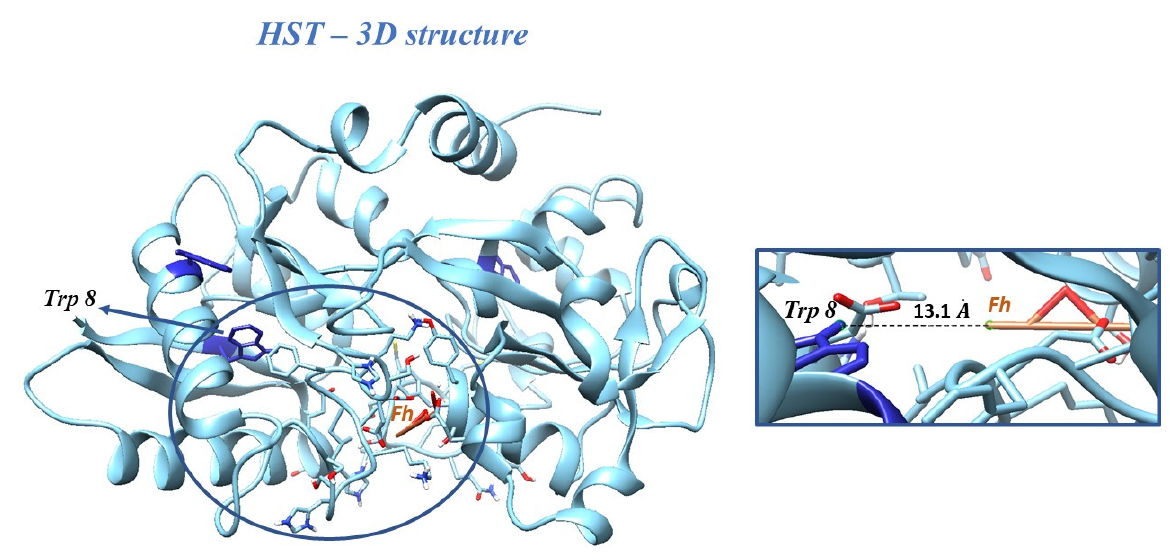
Figure 5. Docking of Fh into the structure of HST. Inset: the binding site of HST for Fh, with the Trp 8 residue and the distance between Trp 8 and Fh.